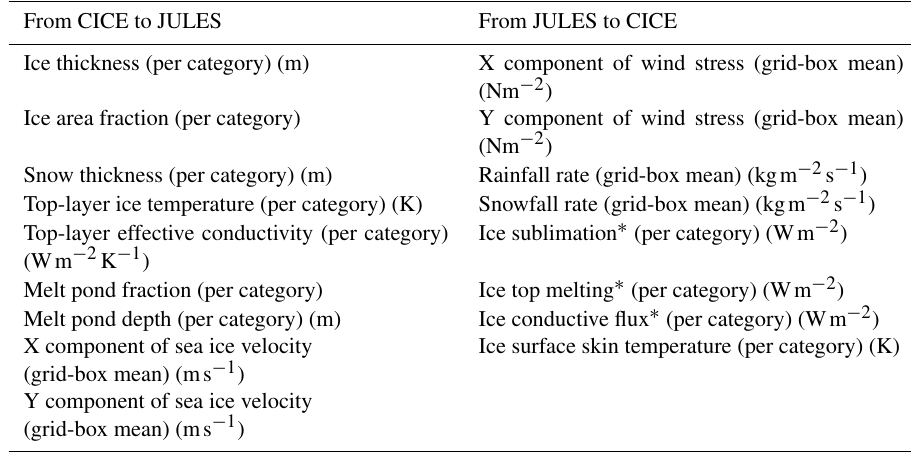
Table C1. Variables passed between CICE and JULES through the OASIS coupler. From CICE to